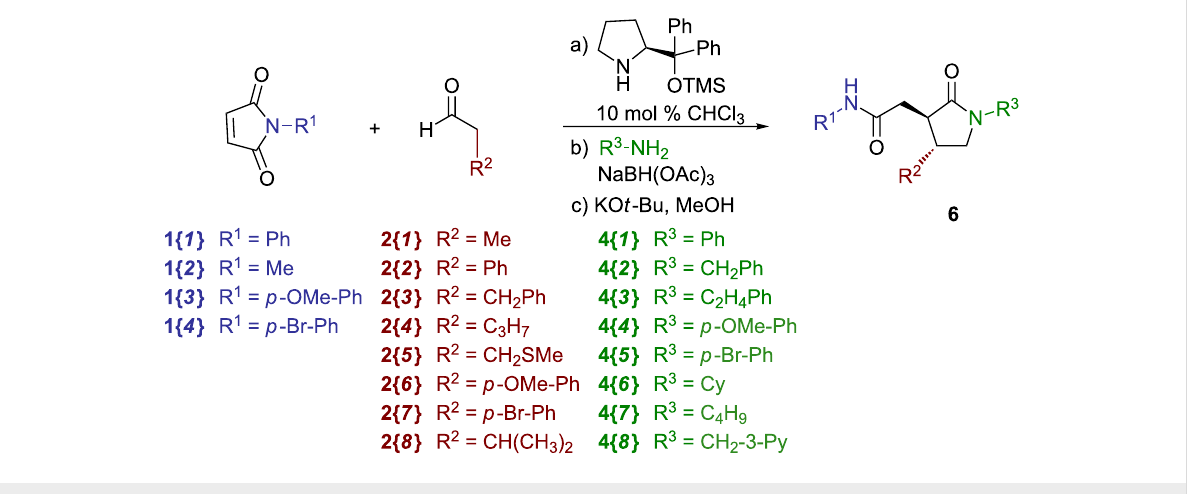
Scheme 5: Chemspeed 4 × 8 × 8 library of γ -lactams 6